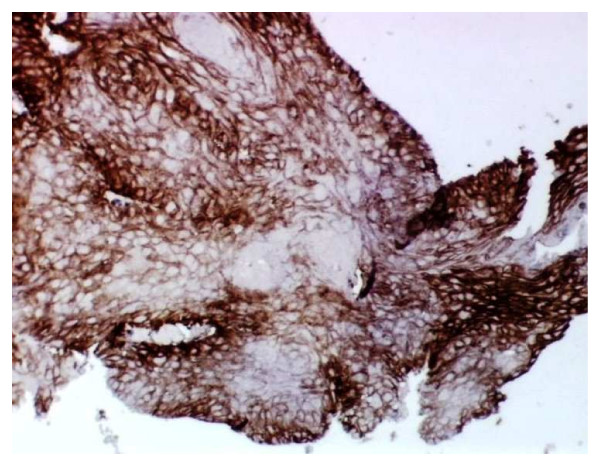
Example of immunohistochemistry for CA IX. Example of biopsy stained for CA IX (×100). This tumor was scored highly positive.